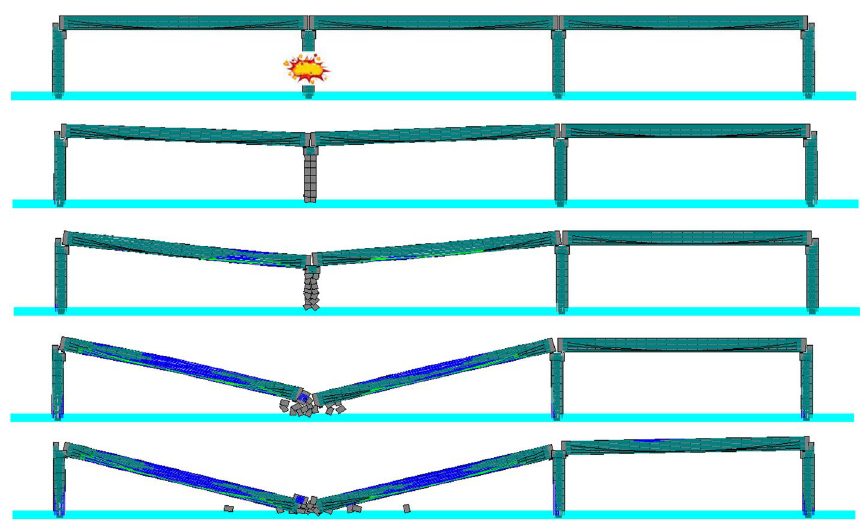
Fig. 13 Collapse mechanism of the prestressed girder due to column removal